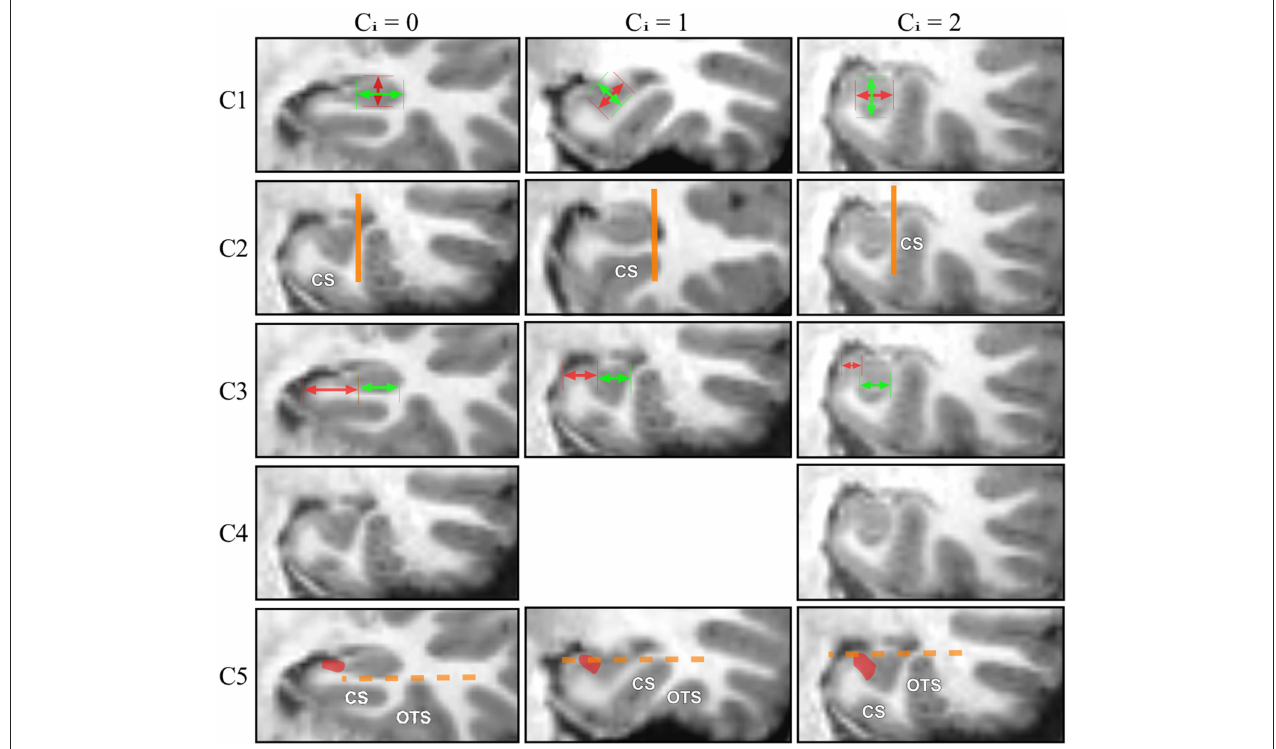
FIGURE 2 | For each IHI criterion, examples corresponding to 3 different grades (0, 1, 2) are displayed.